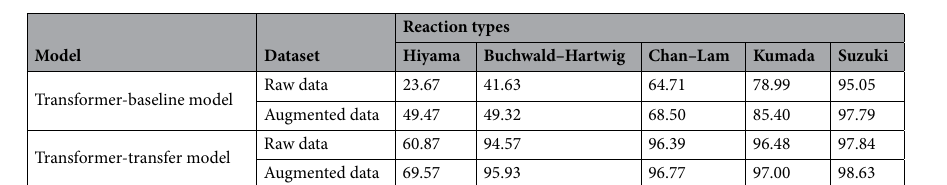
Table 3. Accuracy comparison of several coupling reactions between raw data and augmented data based on the transformer-baseline model and transformer-transfer model.